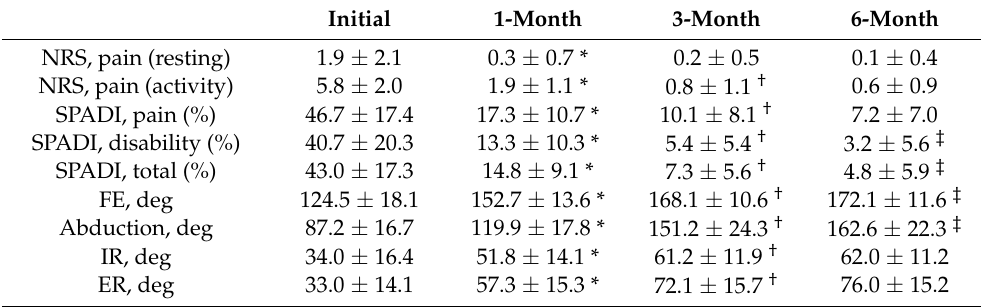
Table 3. Sequential changes in the clinical outcomes of patients with adhesive capsulitis.